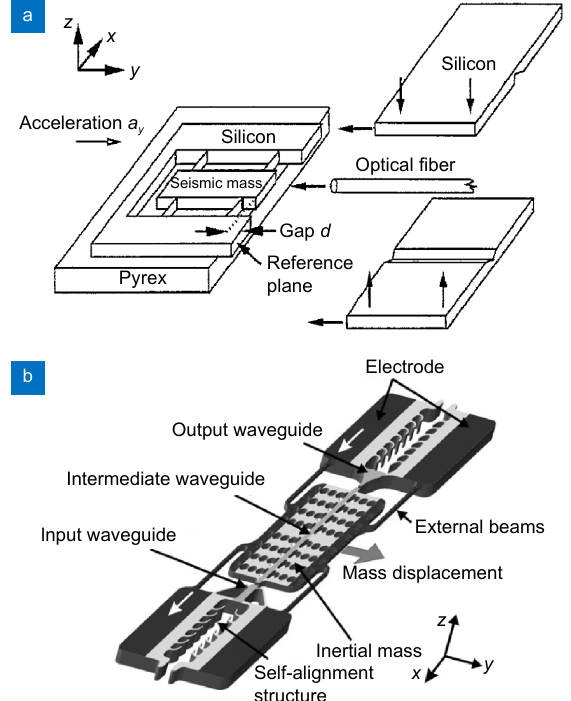
Fig. 5 | ( a ) Schematic of a light intensity based MOEMS accelero- meter by using waveguide. ( b ) Schematic view of the MOEMS accel- erometer based on waveguide. Figure reproduced with permission from: (a) ref. 18 , Elsevier; (b) ref. 19 ,